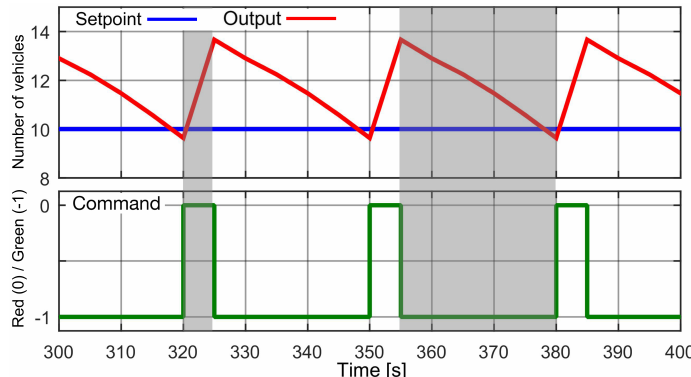
Figure 5. Response of the traffic control system for a single-lane road segment: setpoint R 0 ( t ) = 10 (vehicles, blue), output R ( t ) (vehicles, red), and command U ( t ) = − 1 for green phase (vehicles are released) or U ( t ) = 0 for red phase (vehicles are